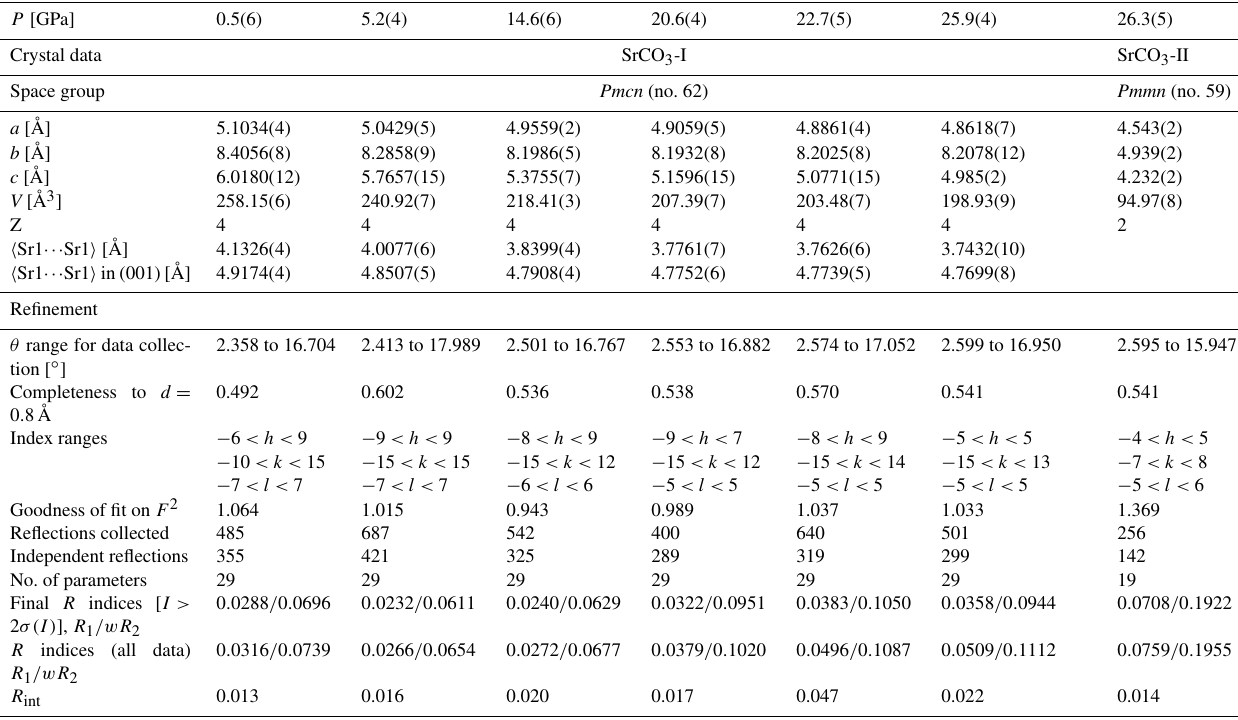
Table 3. Details of single-crystal structure refinements of SrCO 3 -I and SrCO 3 -II between 0.5 and 26.3GPa.